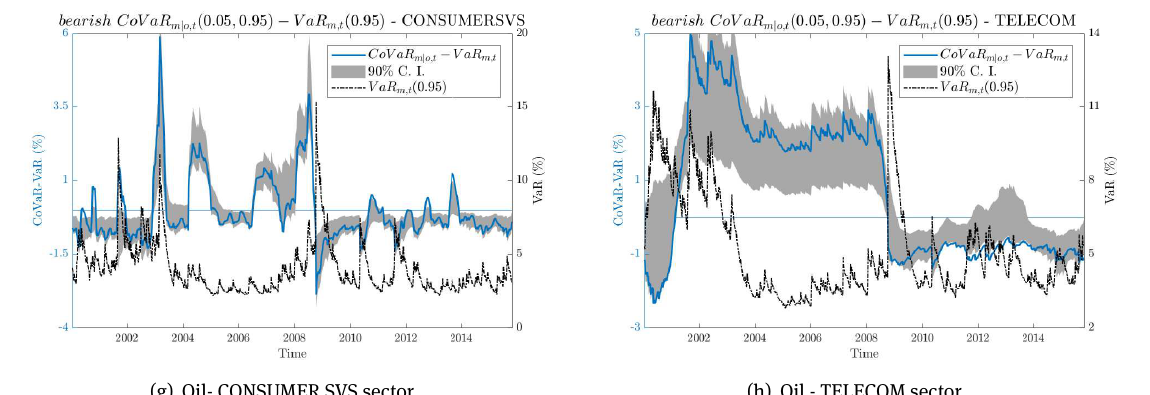
(0.95). Solid blue line m , t